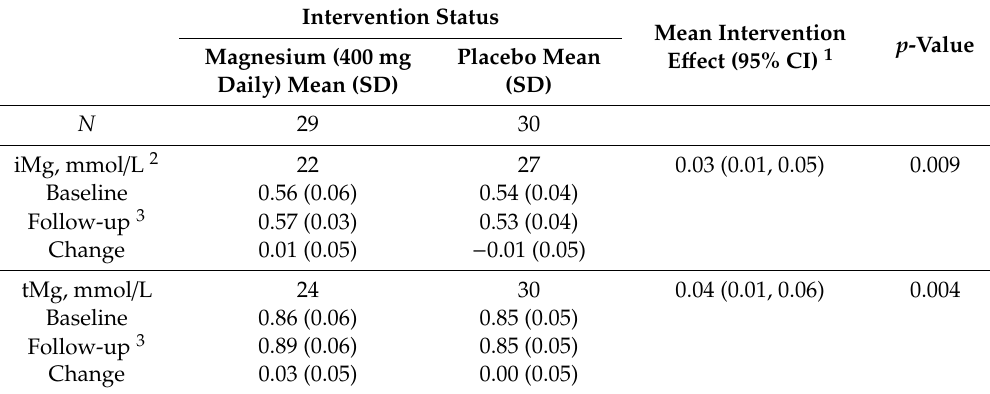
Table 2. Ten-week change in ionized and total magnesium concentrations by treatment group. Intervention Status Mean Intervention E ff ect (95% CI)